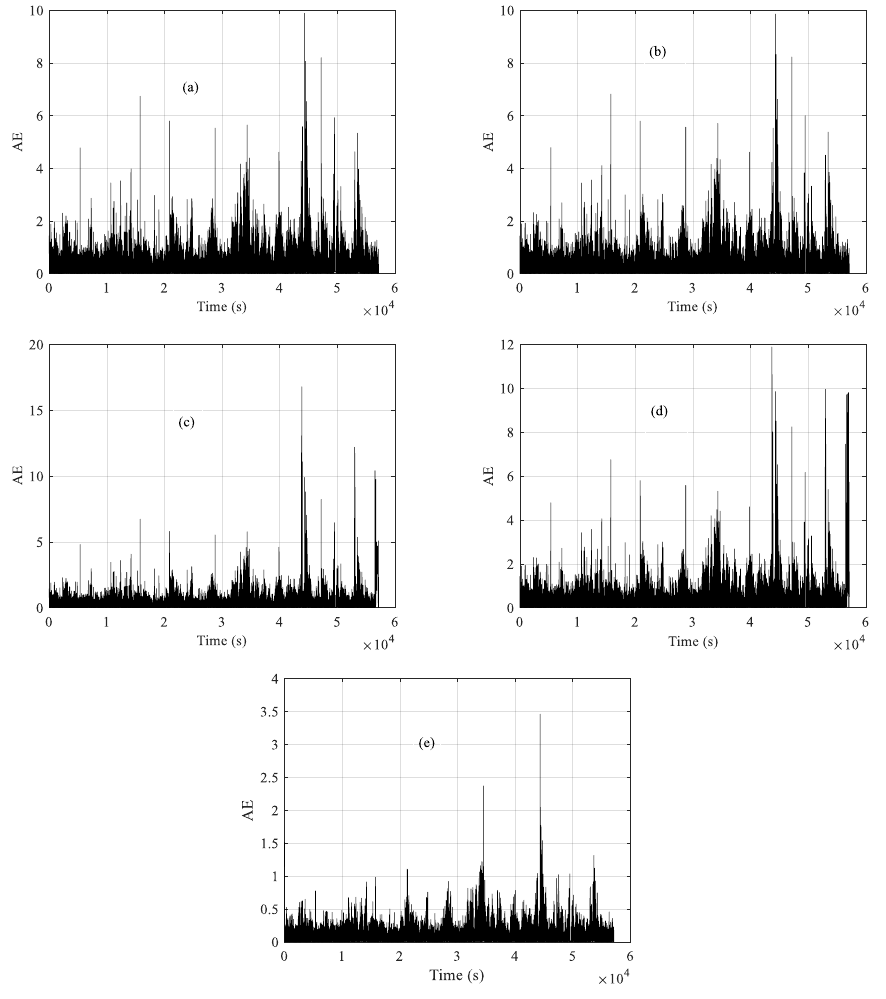
Figure 6. Absolute error of the proposed model corresponding at ( a ) Case#1, ( b ) Case#2, ( c ) Case#3, ( d ) Case#4, and ( e ) Case#5 of the 1-min-ahead prediction horizon.